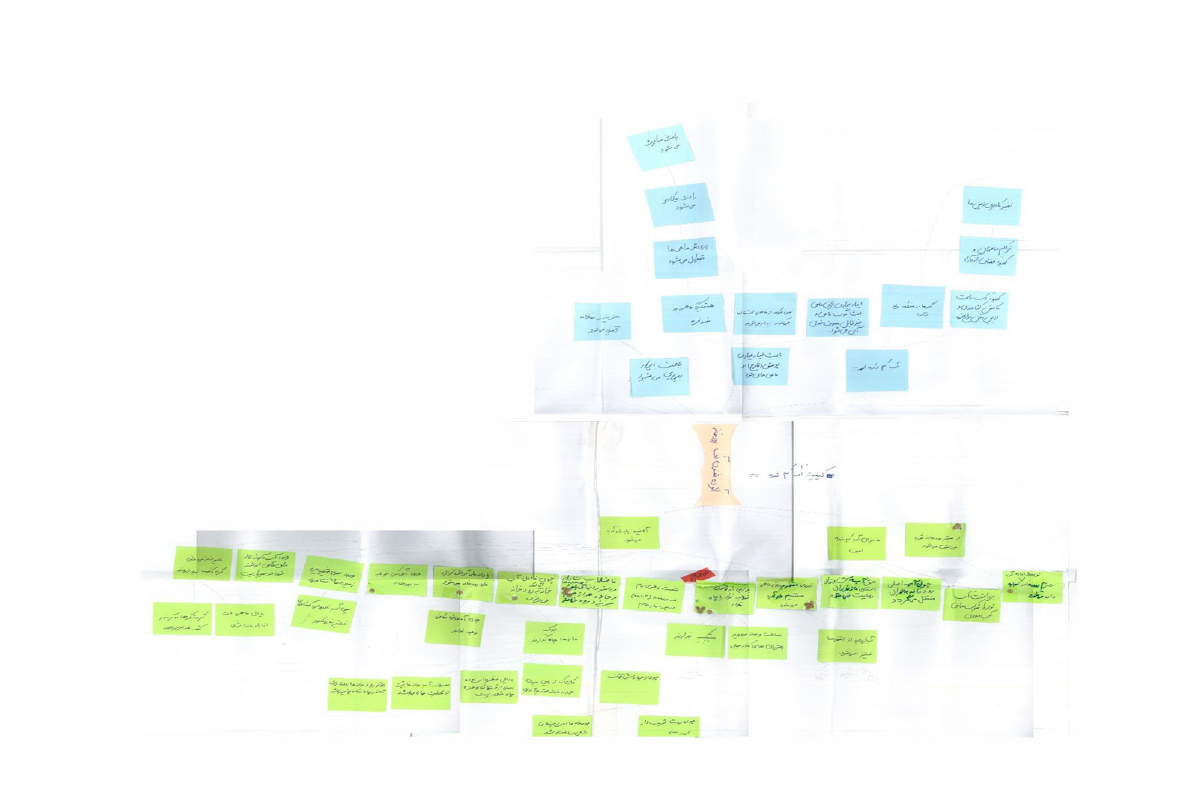
FIGURE8 Water pollution problem tree- Ab-e Ask village. The method’s